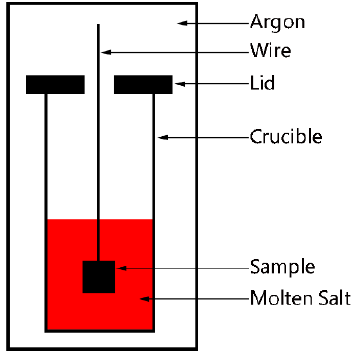
Figure 1. Schematic diagram of the experimental setup.